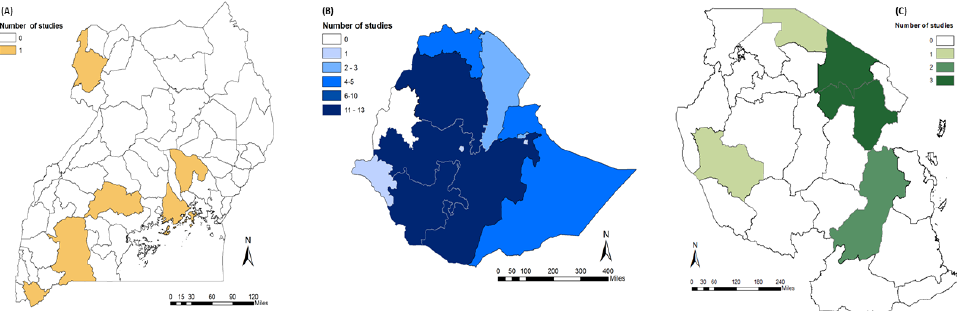
Figure 3. The distribution of studies performed in the 54 reviewed articles. Map ( A ) represents the administrative districts of Uganda. Maps ( B , C ) represent the administrative regions of Ethiopia and Tanzania, respectively. Some articles performed studies in more than one region/district.